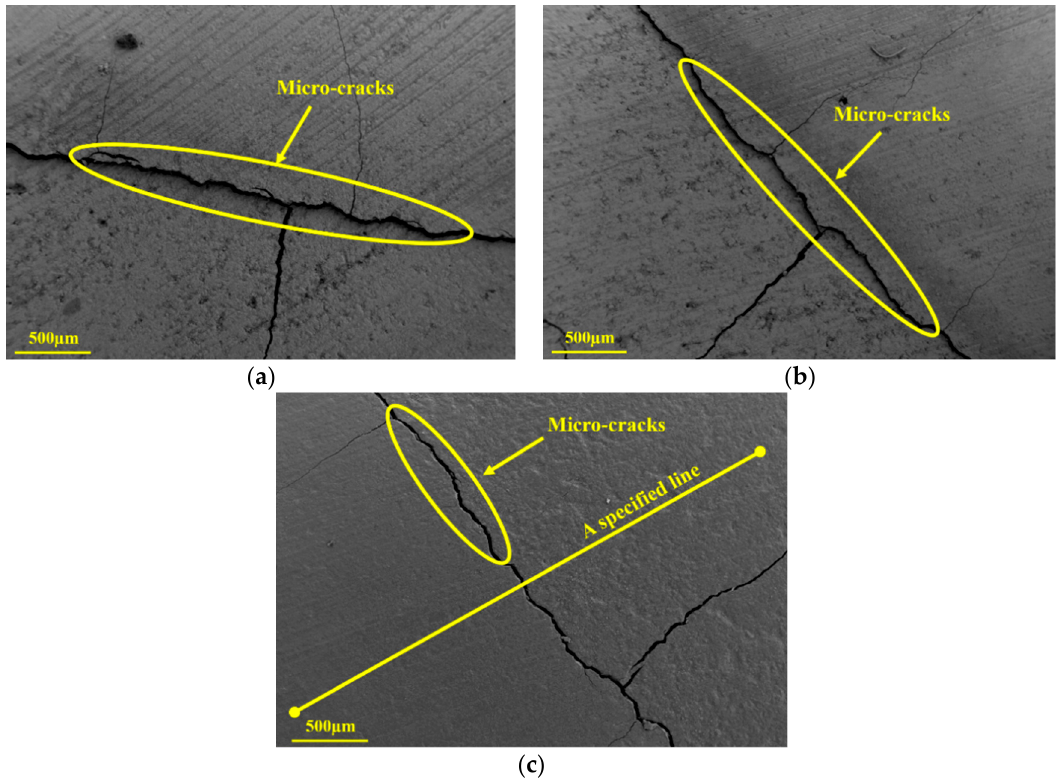
Figure 13. Cutting surfaces of R0, G2, and G4 after leaching for 14 days: ( a ) R0; ( b ) G2; and ( c ) G4.